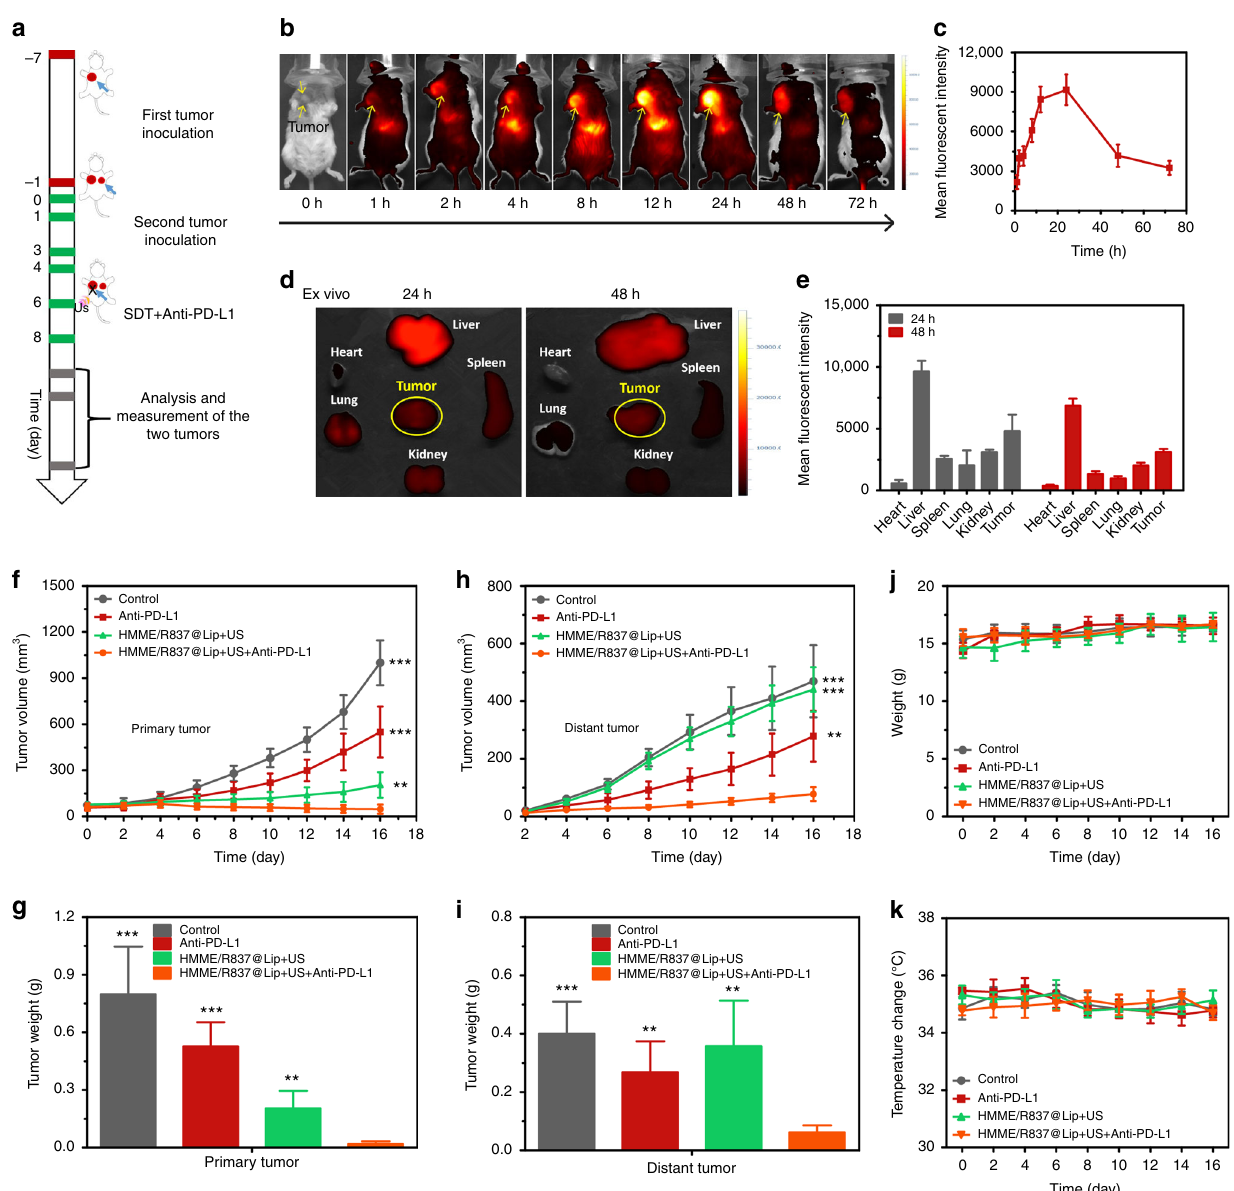
Fig. 5 Synergistic nanosonosensitiser-augmented SDT and immunotherapy for in vivo suppression of mimic distant tumours in a subcutaneous tumour model. a Schematic showing the experiment design for in vivo evaluations. Mice bearing 4T1 subcutaneous tumours on both sides were used in this experiment. Tumours on the right side of the check were designed as “ primary tumour ” for SDT, and those on the left side were set as “ mimic distant tumours ” without SDT; b in vivo fl uorescence images to reveal the biodistribution of HMME/R837@Lip post i.v. injection into 4T1-tumour-bearing mice at the indicated time points. Yellow arrows indicate tumours; c the accumulation curve of HMME/R837@Lip in the tumour tissue by measuring the fl uorescence intensity of tumours at different time points post i.v. injection, error bars are based on SD ( n = 3); d the ex vivo fl uorescence image of major organs and tumour dissected from the mouse 24 and 48 h post injection and ( e ) quanti fi cation analysis of the tissue content of HMME/R837@Lip by testing the corresponding fl uorescence intensity; data are expressed as means± SD ( n = 3); f , h primary ( f ) and distant ( h ) tumours growth curves of different groups of tumour-bearing mice after various treatments as indicated in the fi gure. Error bars are based on SD ( n = 5); average weights of g primary and i distant tumours at the end of treatment; time-dependent body temperature ( j ) and weight ( k ) surveillance of mice ( n = 5) after different treatments. Statistical signi fi cances were calculated via Student ’ s t test, ** p < 0.01 and *** p <